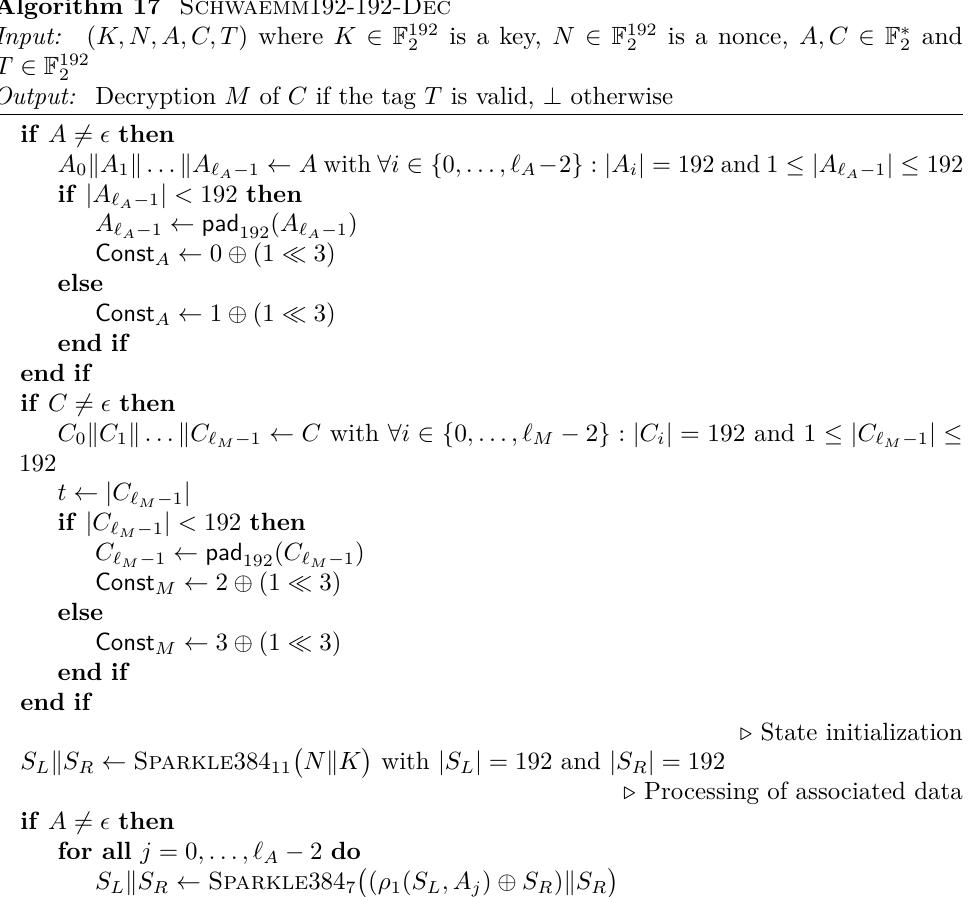
Algorithm 17 Schwaemm 192-192